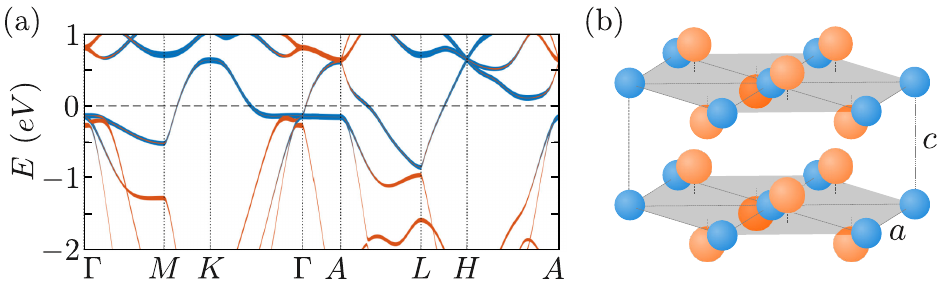
Figure 1: (a) The ab initio bandstructure of VSe bands indicated. Orange corresponds to Se character, and blue indicates V charac- ter. The single band crossing the Fermi level was used to compute the electronic susceptibility. (b) Sketch of the layered atomic structure of 1 T -VSe